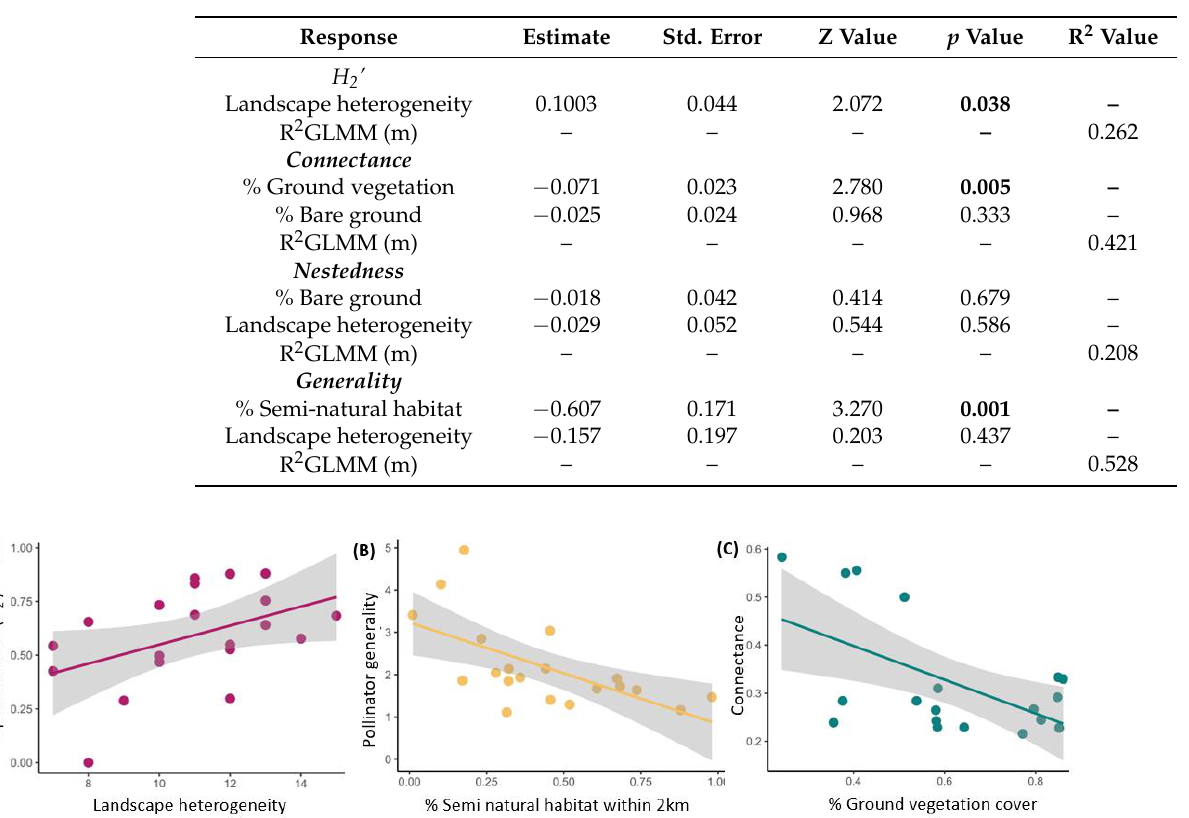
Table 1. The final results of the averaged linear mixed models with AIC < 2 for our pollen-based plant-pollinator networks. The full models included the following predictor variables: percent ground vegetation, percent bare ground, percent flower abundance, percent semi-natural habitat within a 2 km radius, and landscape heterogeneity.